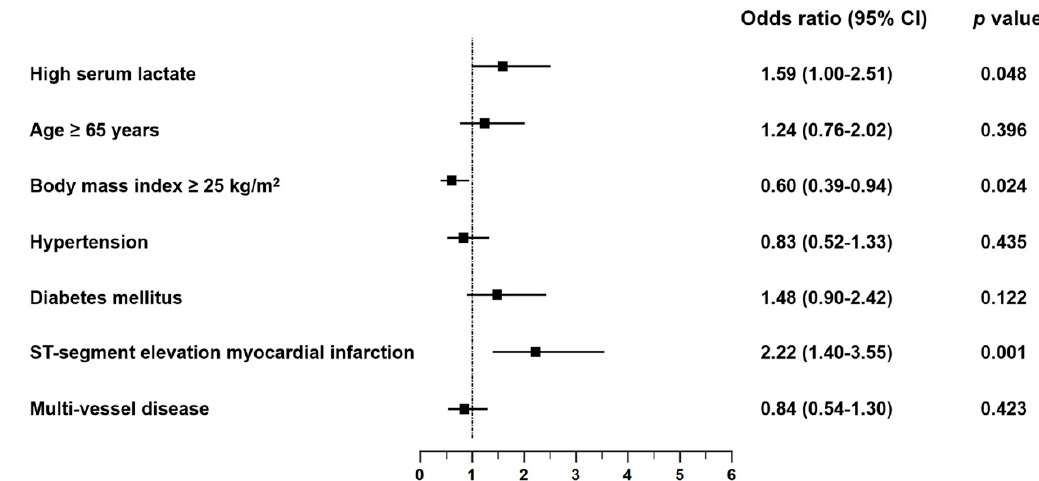
Figure 4. Predictors of large myocardial infarct. Forest plots show the results of multivariate analysis of predictors of large myocardial infarct. CI = confidence interval.